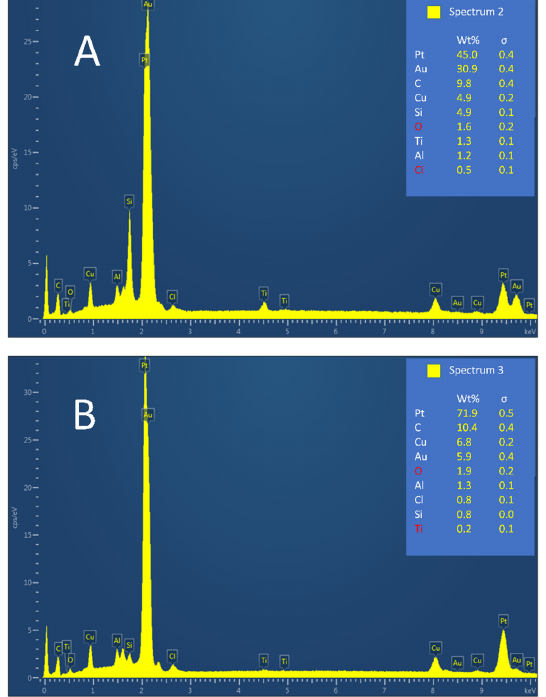
Figure 4. EDX spectra of the modified electrode surface. Electrode composition after 100 cycles ( A ). Electrode composition after 300 cycles ( B ).